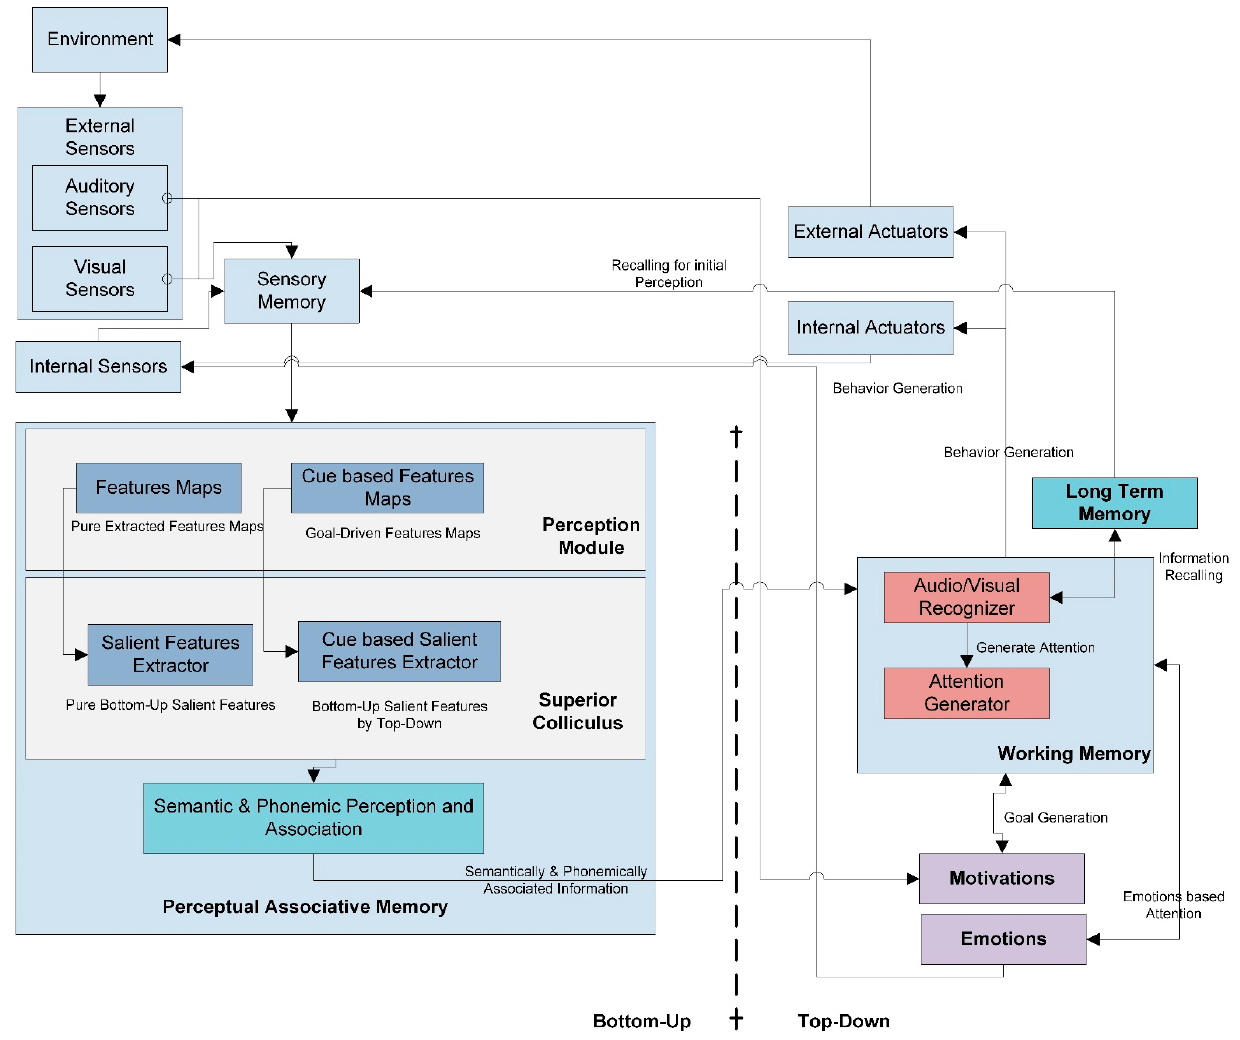
Figure 1. Parallel selective attention (PSA) model. This model represents the overall working of the bottom-up and top-down attention processes. This model also defines the link of various memories for generation and regulates the attention process.